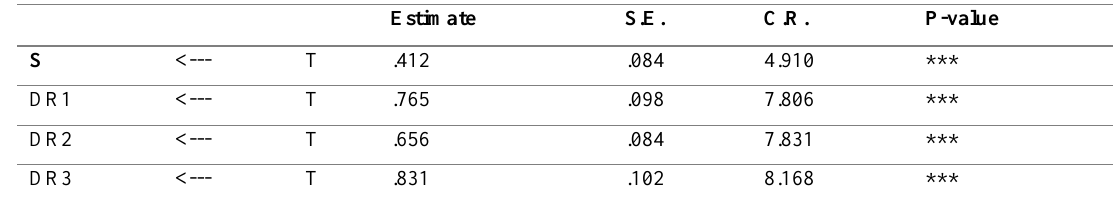
Table 9: Regression Weight and CR Values for Transparency